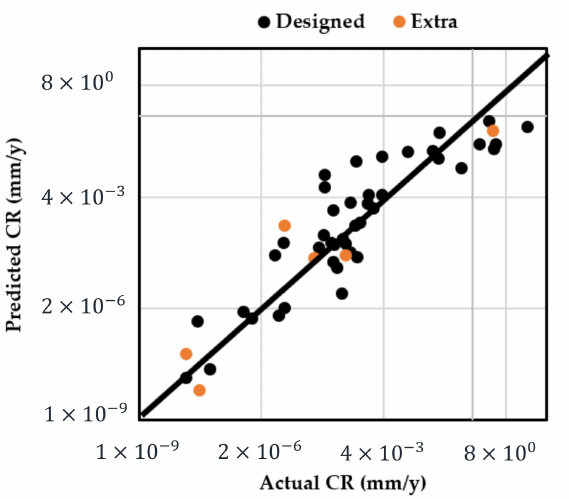
Figure 3. Predicted CR using the established mathematical model vs. actual measured CR (designed points: runs 1–42; extra test points: runs X1–X6 in Table